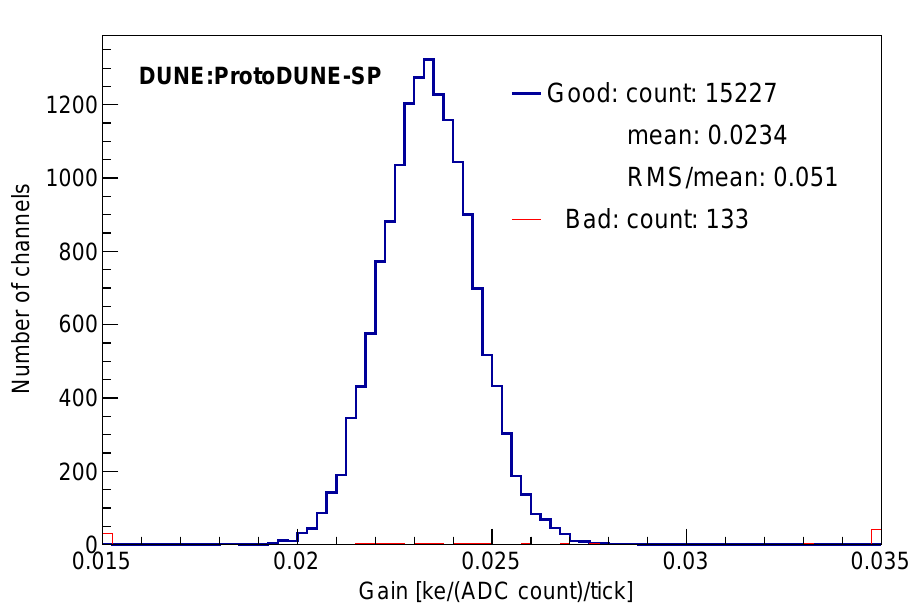
Figure 3. Distribution of fitted gains for good (blue) and bad/noisy (red) channels. The legend indicates the number of channels in each category and gives the mean (23.4 e/(analog-to-digital converter (ADC) count)/tick)) and RMS/mean (5.1%) for the good channels. This figure is from